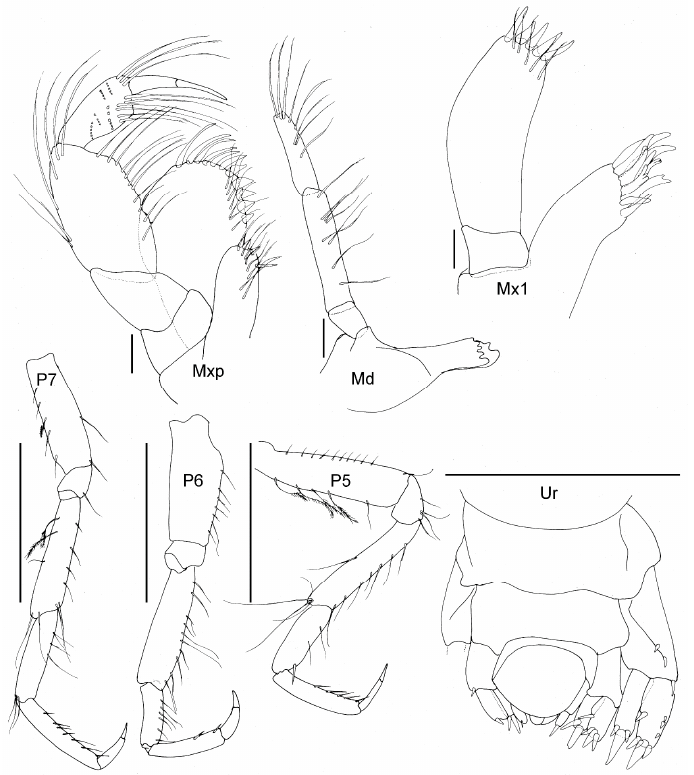
Figure 5. Unciola conchicola sp. nov. holotype male, 10 mm, ZMHK-62083, South Island, Iceland Basin, 1921 m. Scale: 0.5 mm.